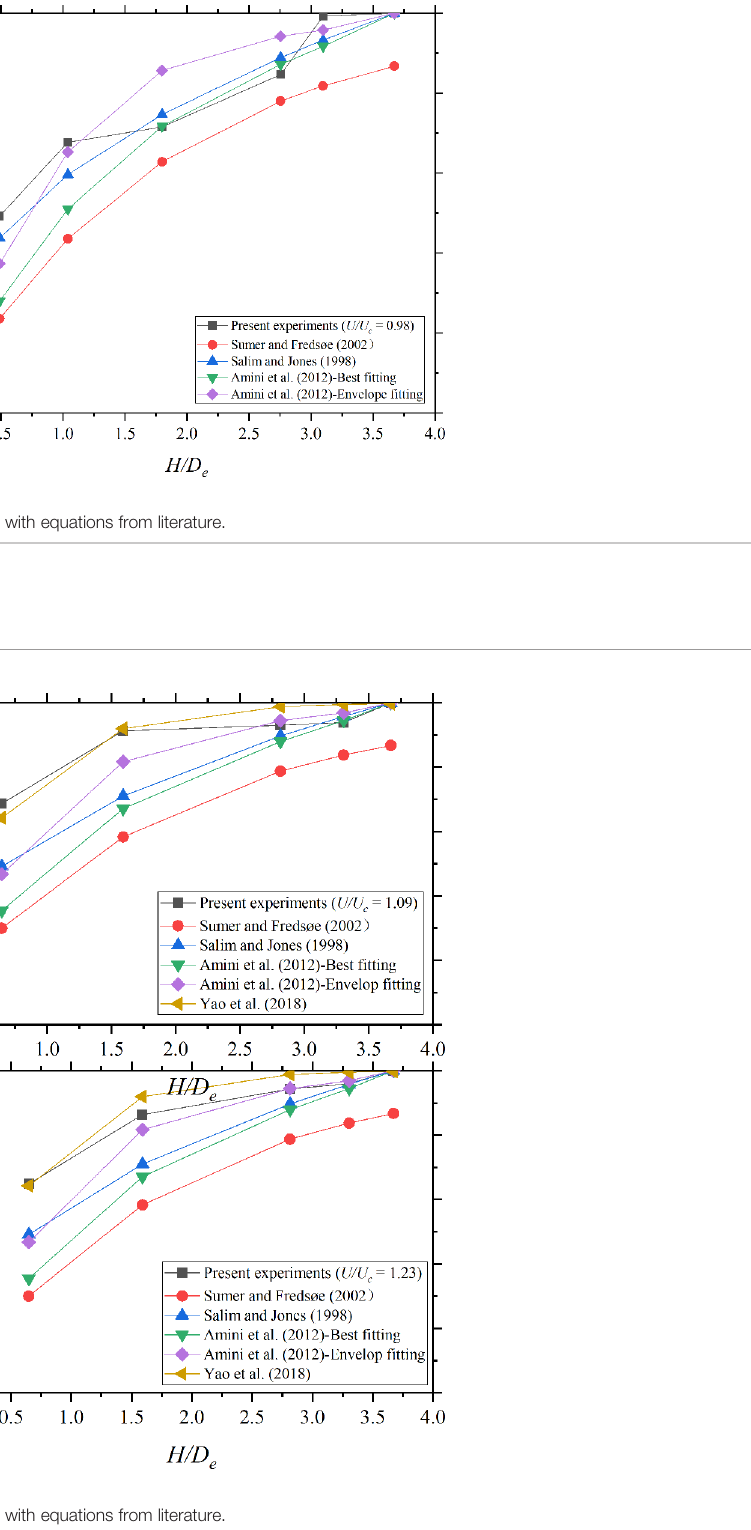
FIGURE 9 | K h values of the present experiments compared with equations from